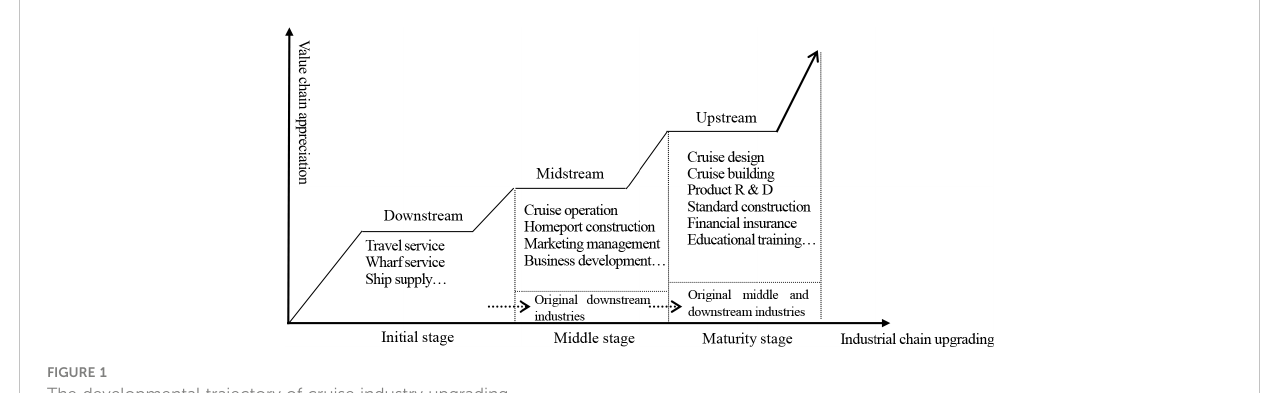
FIGURE 1 The developmental trajectory of cruise industry